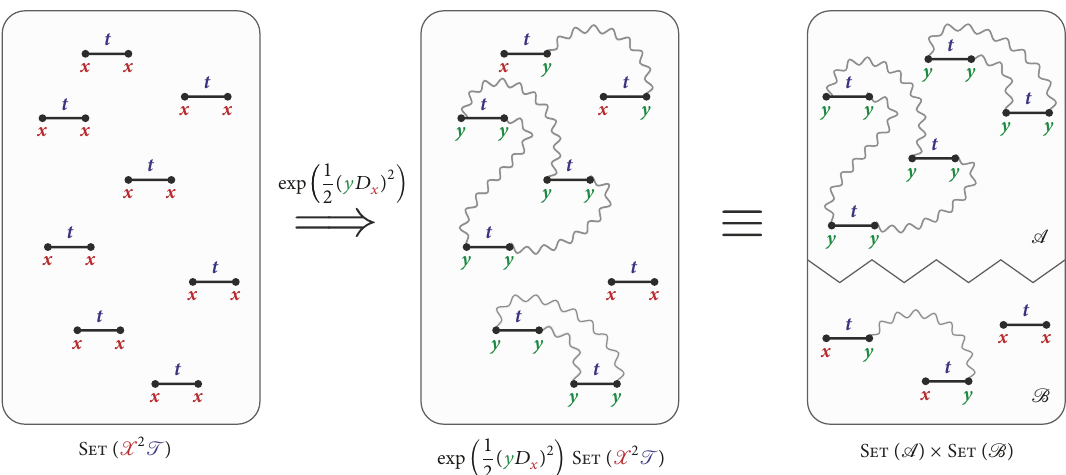
Figure 2: On the left, there is an instance of a structure in C = Set ( X 2 T ) , i.e., a set of labelled atoms T which have additional finer structure comprised of two atoms of type X (say the left and the right one). In the middle, example of a structure arising from the action of exp ((1/2)(𝑦𝐷 𝑥 ) 2 ) on C which is obtained by selecting a set of dubletons of X atoms and replacing them by atoms of type Y . Selected pairs are depicted by wavy lines. On the right, decomposition of such a structure into a product of two sets comprising, respectively, closed ( A ) and open ( B )